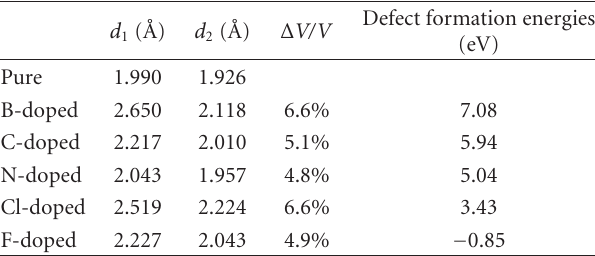
Table 2: Calculated bond lengths, lattice variation, and defect formation